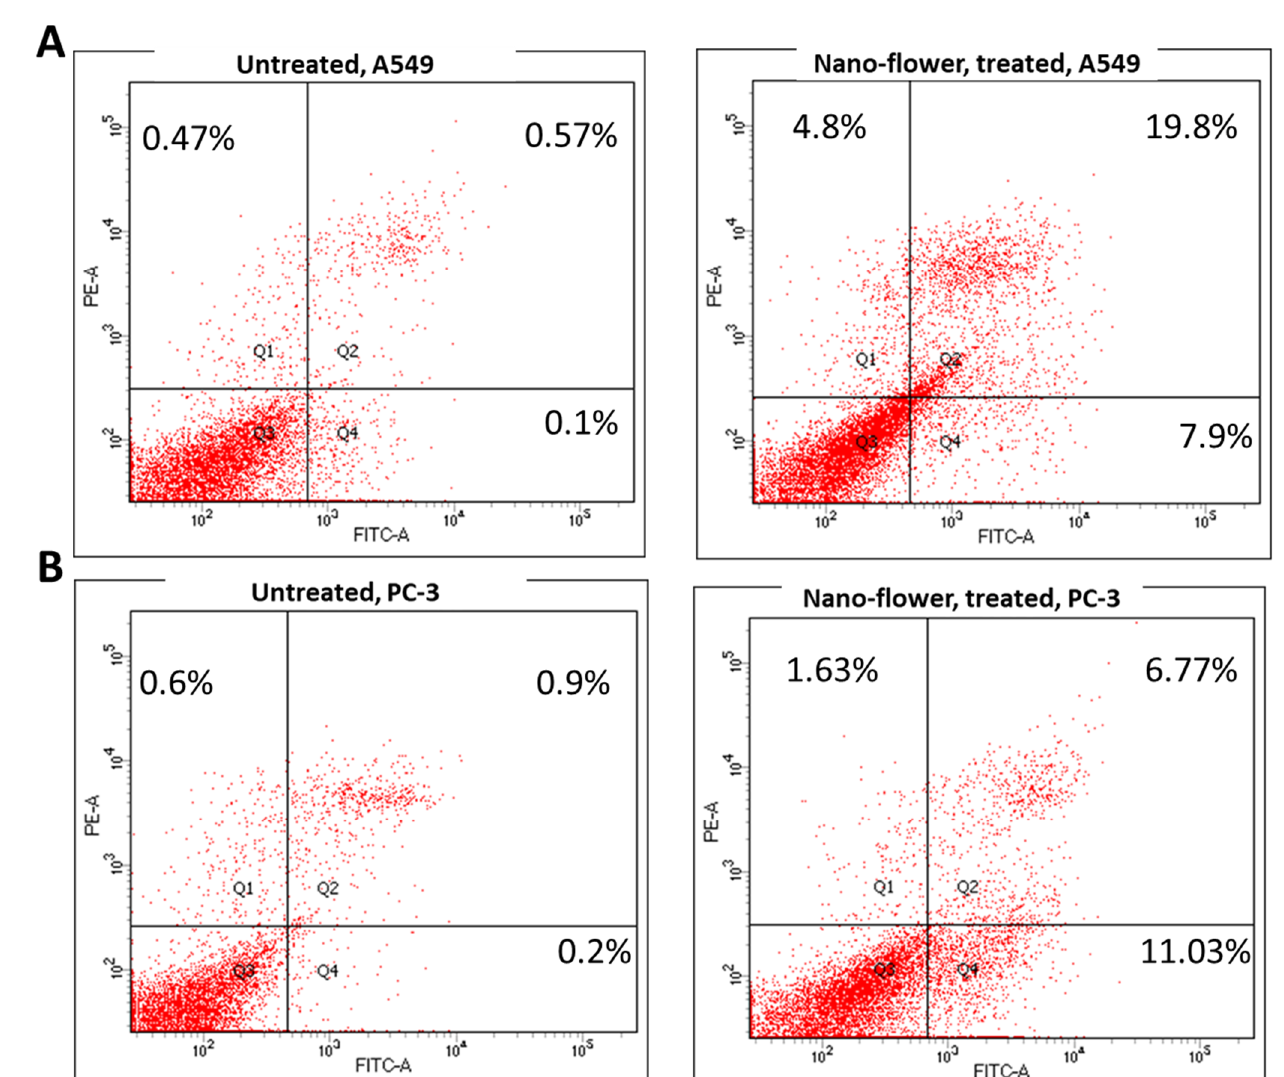
Figure 4. Cytograms for apoptosis–necrosis assessment using flow cytometry. ( A ) Annexin V/PI staining of untreated and treated A549 cancer cells with flower extract AgNPs (IC 50 = 1.52 μM, 48 h). ( B ) Annexin V/PI staining of untreated and treated A549 cancer cells with flower extract AgNPs (IC 50 = 2.47 μM, 48 h). Q1: necrosis, Q2: late apoptosis, Q4: early apoptosis (lower panel).